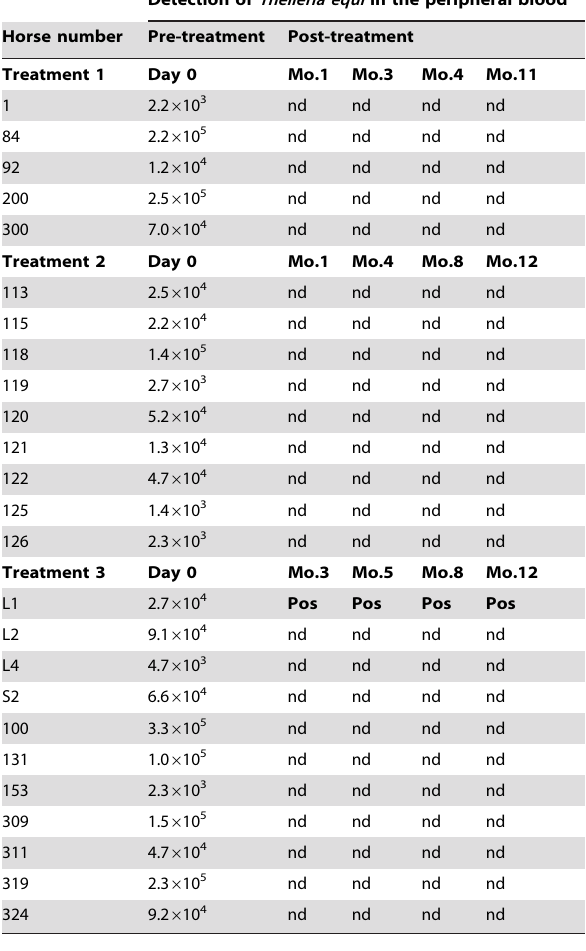
Table 1. Elimination of Theileria equi in the peripheral blood following imidocarb dipropionate treatment.